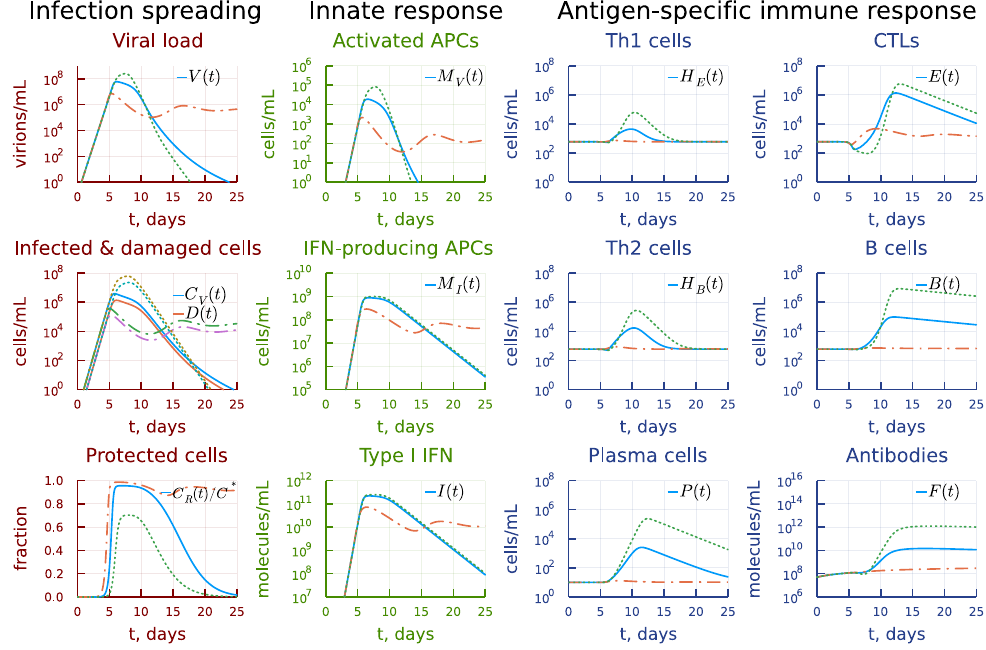
relative to baseline value. I